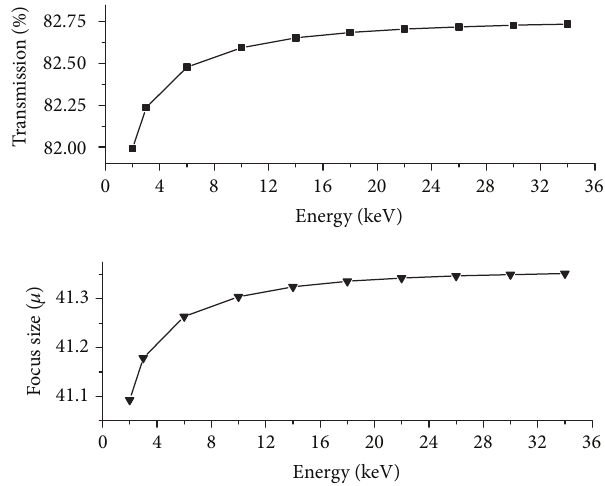
Figure 4: Percent transmission and focus size of the excitation channel lens at 15 mm from its output versus the incident energy. Here the focus size is represented by the FWHM of the transversal cross section of the emergent beam. It is given by product of 𝜎 𝐴 by